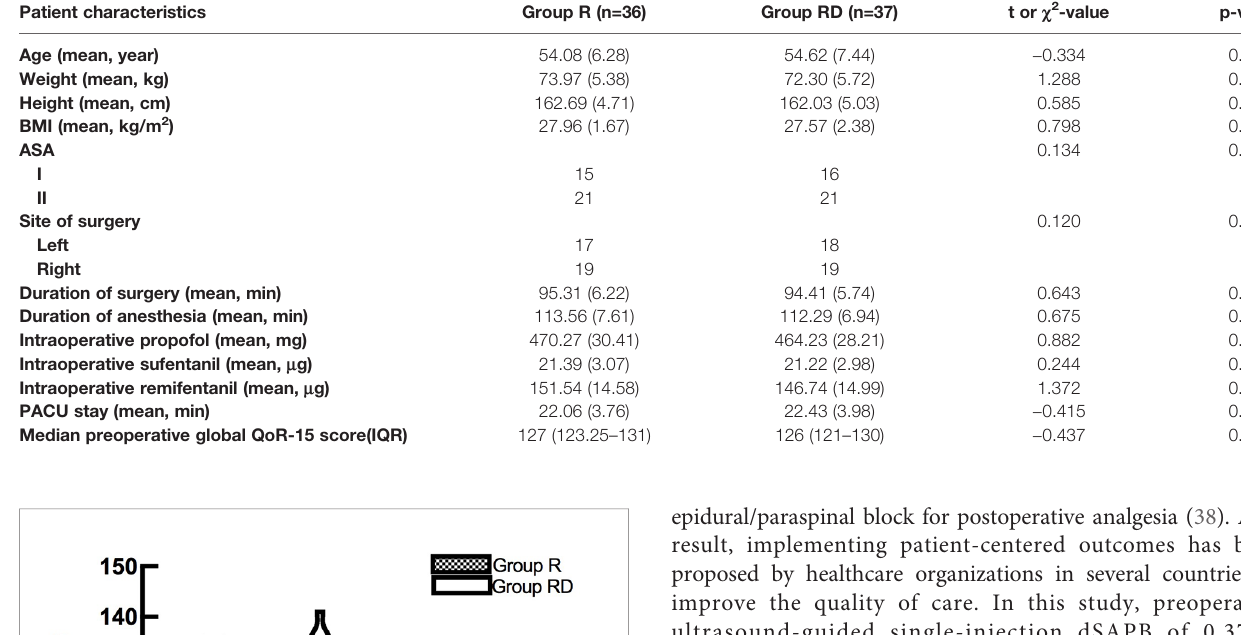
TABLE 1 | Demographic characteristics of the participants. Patient characteristics